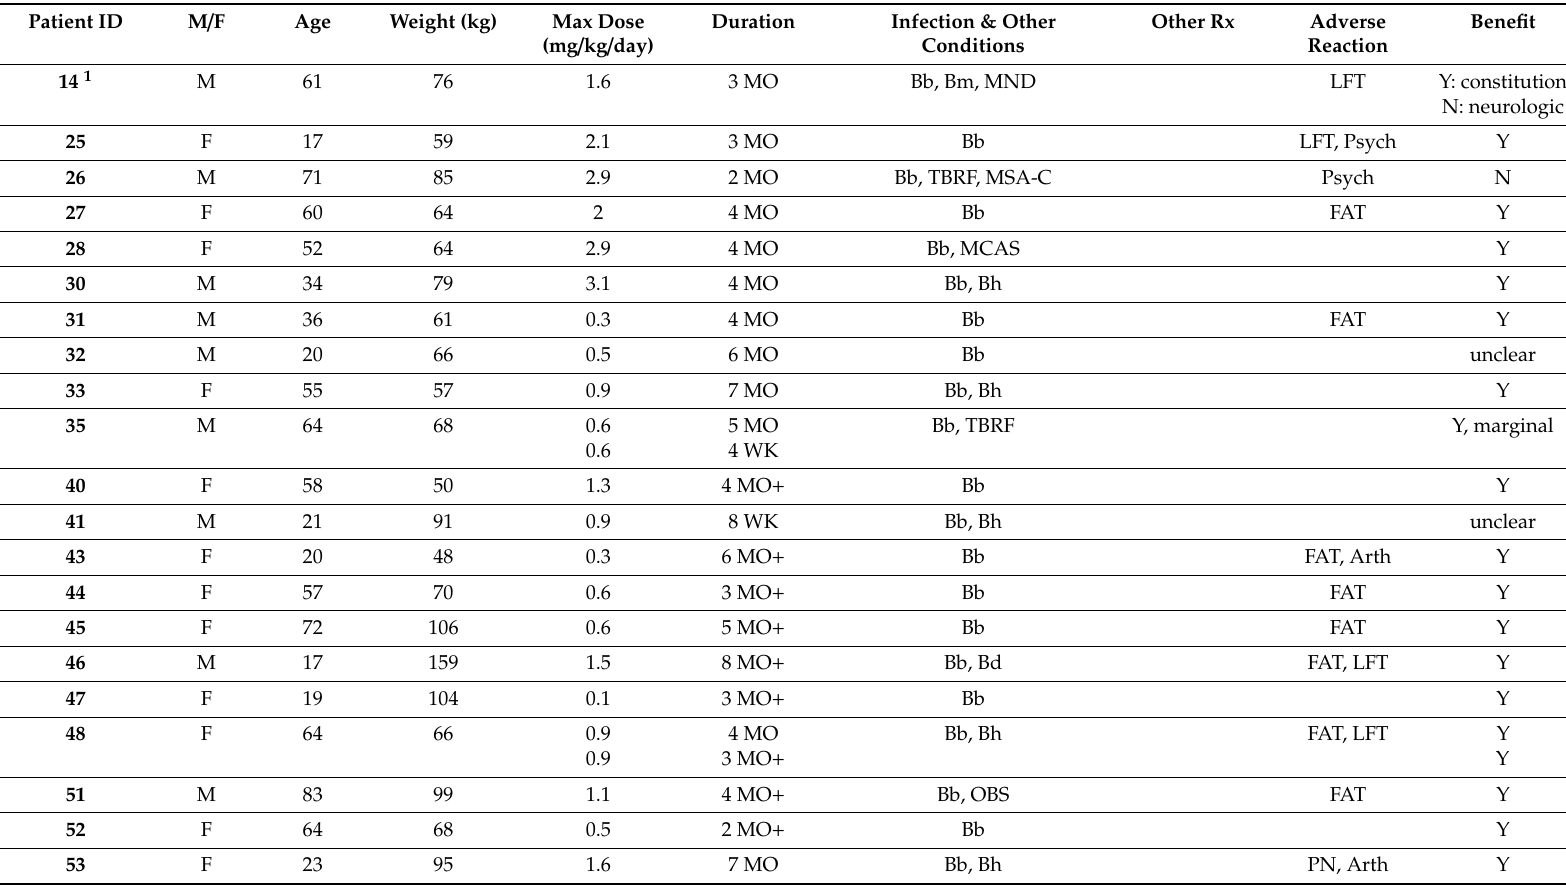
Table 2. Summary of patients on low dose ( < 4 mg / kg / day) disulfiram ( n =